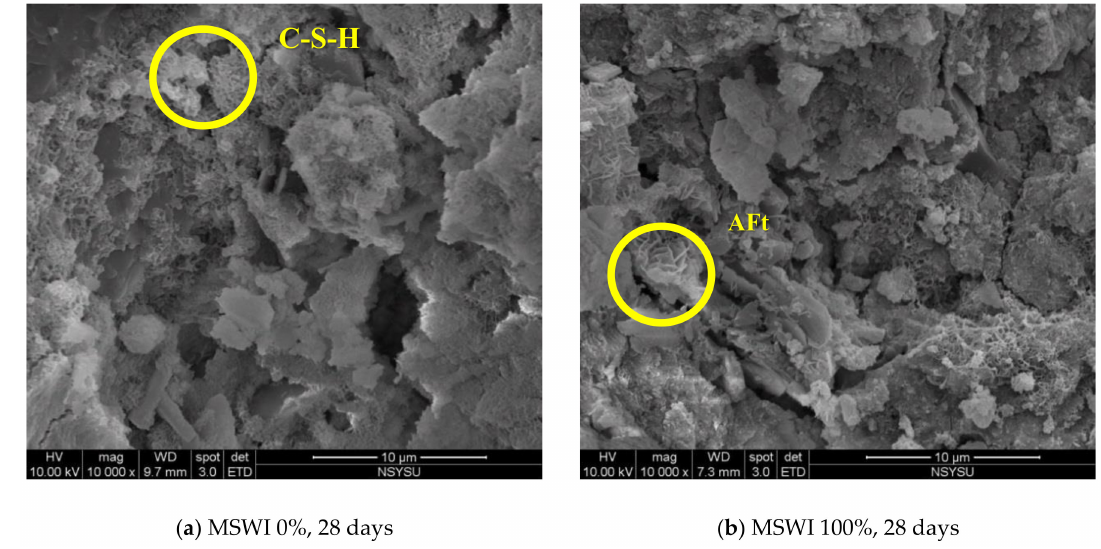
Figure 8. Scanning electron microscopy (SEM) image of MSWI CLSM